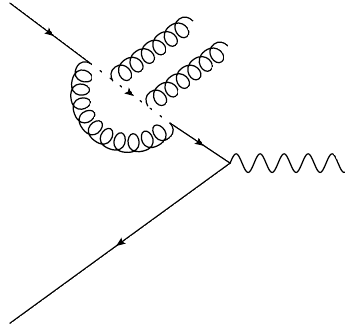
Figure 4 . Physical intepretation of the soft region occuring for the (cid:12)rst time at N 3 LO: an incoming collinear quark (or antiquark) turns into a soft quark by emitting a collinear gluon. The soft quark then emits two soft